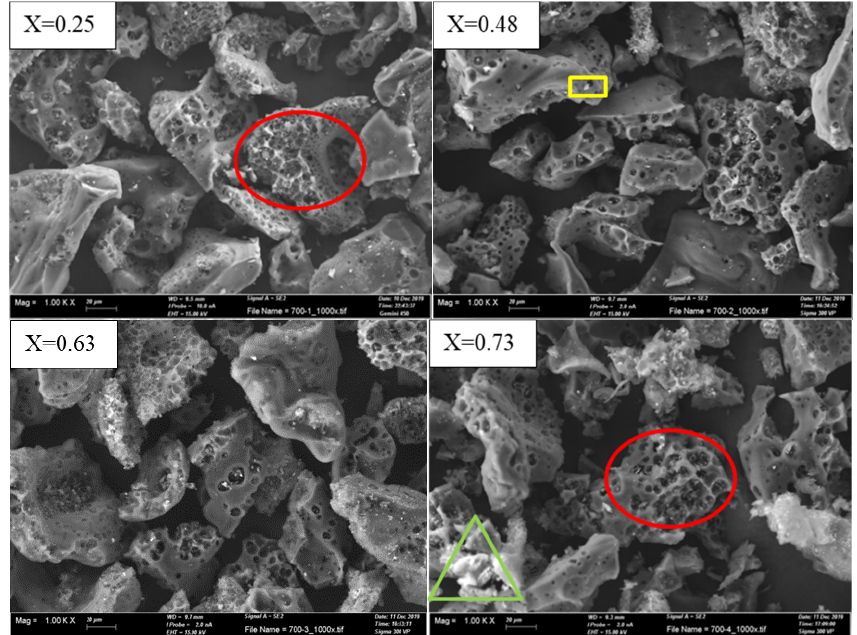
Figure 8. SEM images (1000× magnification) of char with different carbon conversions prepared from char gasification in H 2 O at 700 °C.